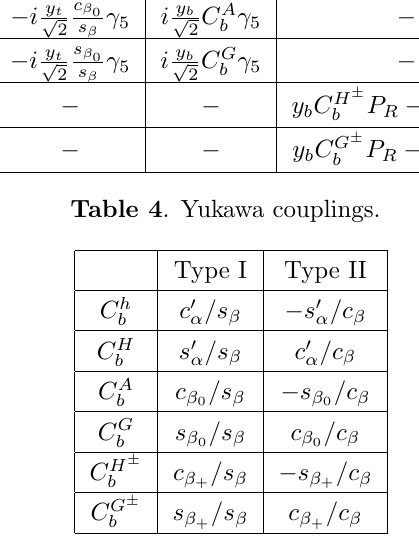
Table 5 . Coe(cid:14)cients for type I and II